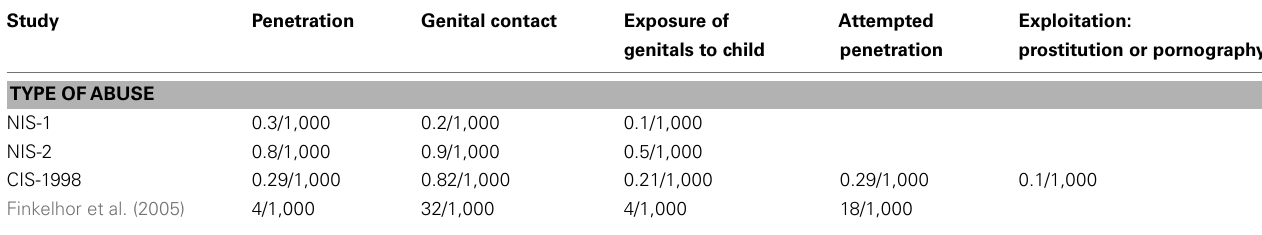
Table 2 | Rates for incidence of child sexual abuse (CSA) by type of